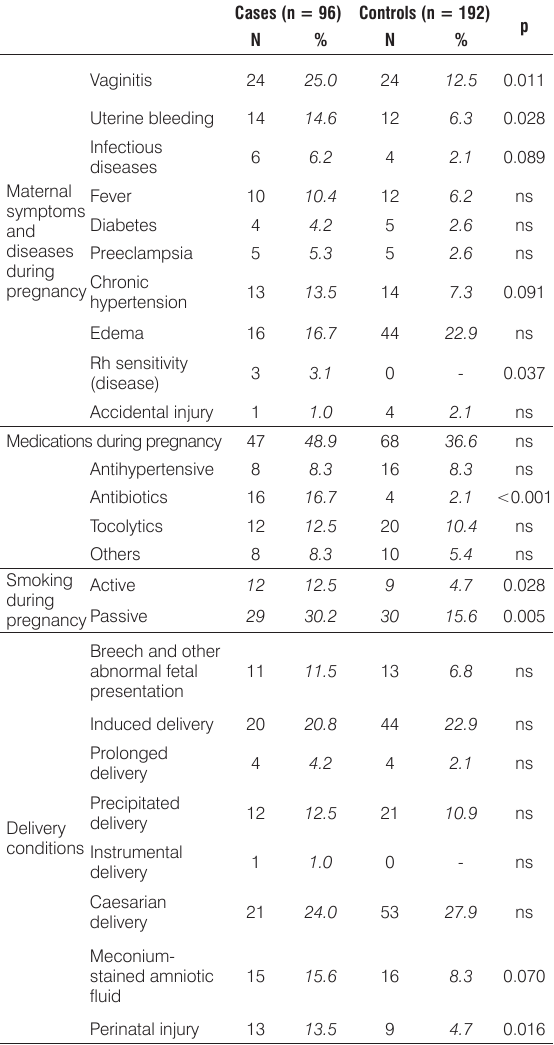
Table 2. Perinatal characteristics of cases and controls.